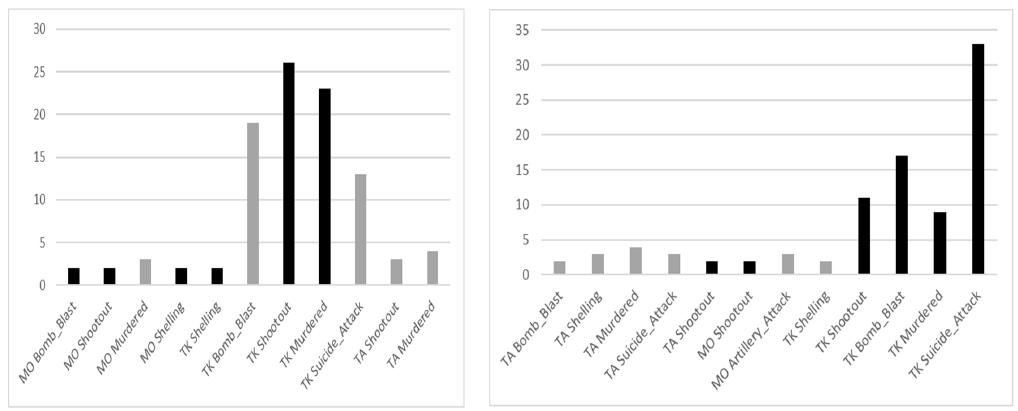
Figure 14. Cluster analysis for Balouchistan ( left ) and Khyber Pakhtunkhaa ( right ), collectively for all events, for the time period 1988–2012.